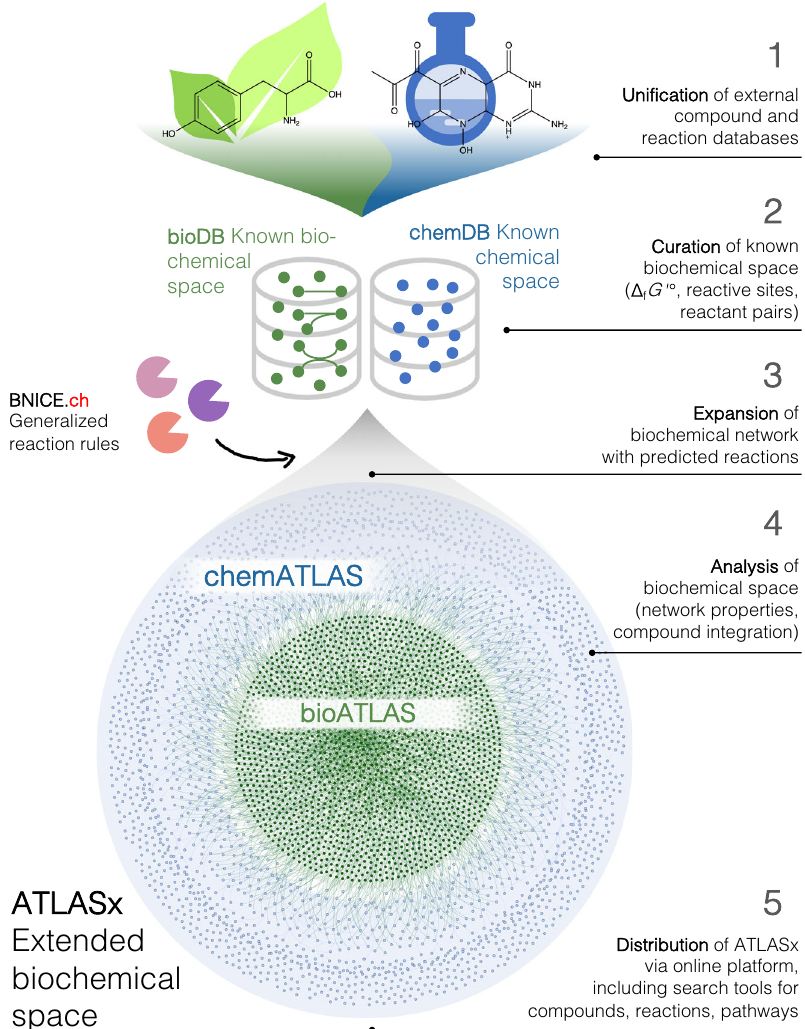
Fig. 1 ATLAS work fl ow applied to known biological and bioactive compounds. 1. Uni fi cation- collection of metabolic reactions and biochemical compounds from different publicly available databases, which were merged into a consistent and duplicate-free database, called bioDB. 2. Curation- compounds were annotated with molecular identi fi ers and reactions were annotated with reaction mechanisms. 3. Expansion- generalized reaction rules from BNICE.ch were applied to bioDB compounds to generate all possible reactions producing known biological or chemical products. 4. Analysis- the connectivity of the biochemical reaction networks was analyzed before and after reaction prediction, as well as the integration of compounds not previously connected in known biochemical networks. 5. Distribution- the results were made available online (https://lcsb-databases.ep fl .ch/Atlas2). Δ f G ʹ °: estimated Gibbs free energy of formation for compounds under biological